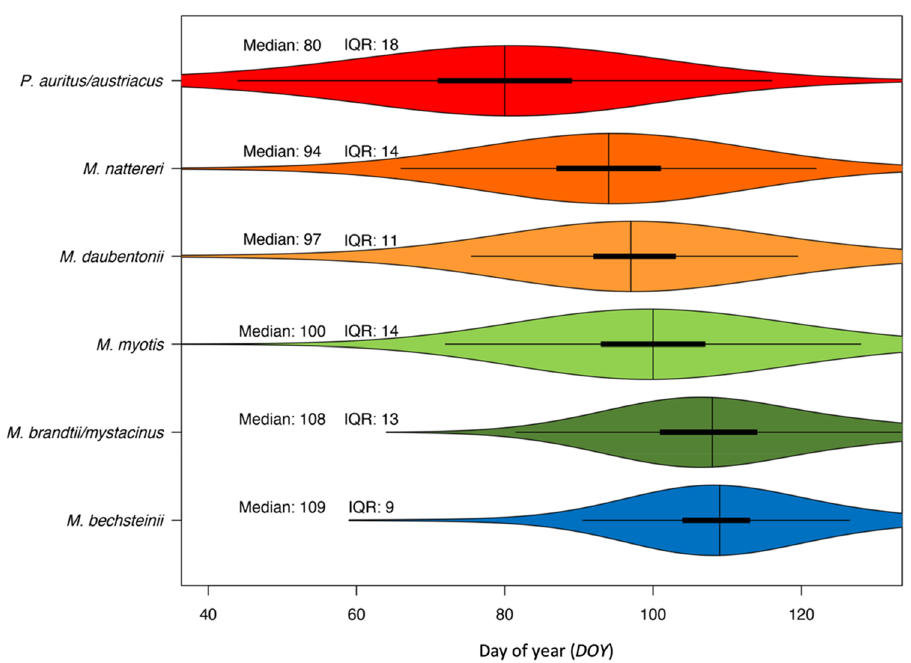
Figure 3. Temporal duration and median of increased spring activity of bat species across five hibernacula; the interquartile range (IQR) is an indicator for the degree of synchronization (without outliers); colours according to Fig.